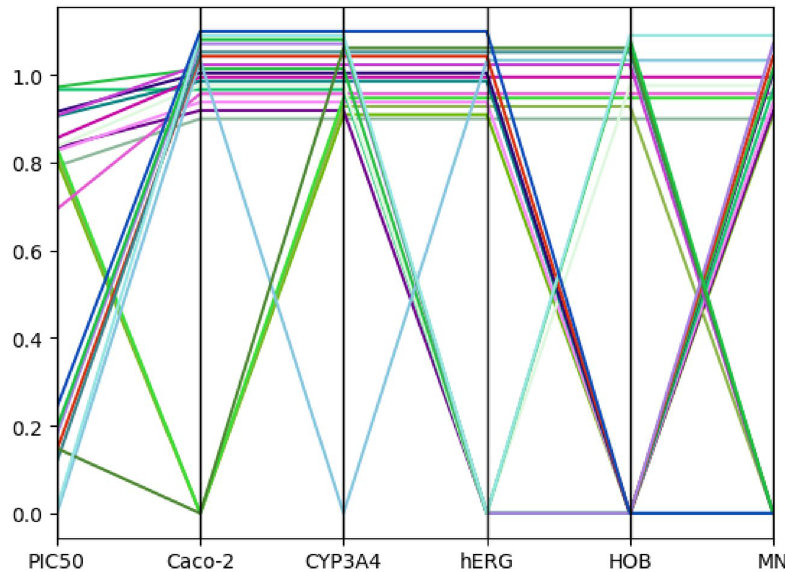
Figure 2. Optimization target conflict